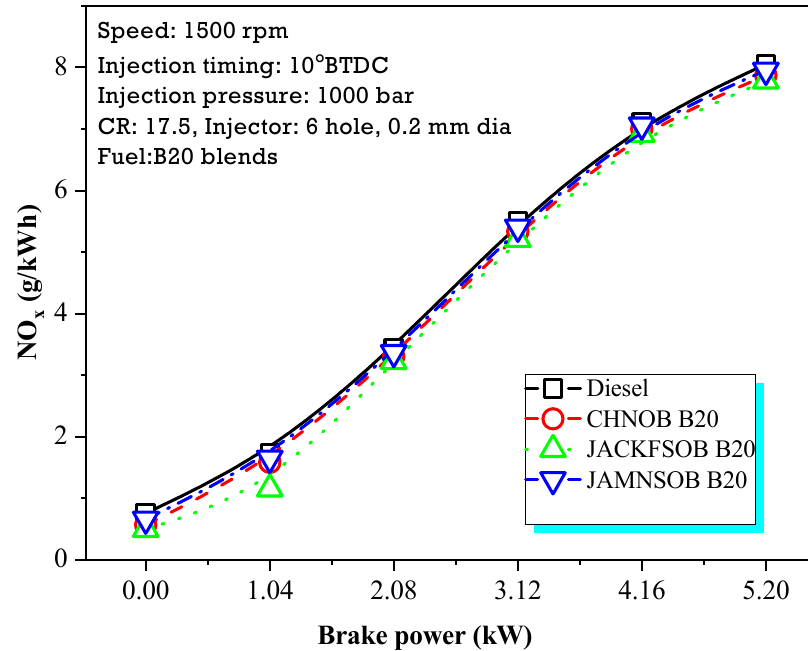
Figure 10. Variation of NOx emissions vs. BP.